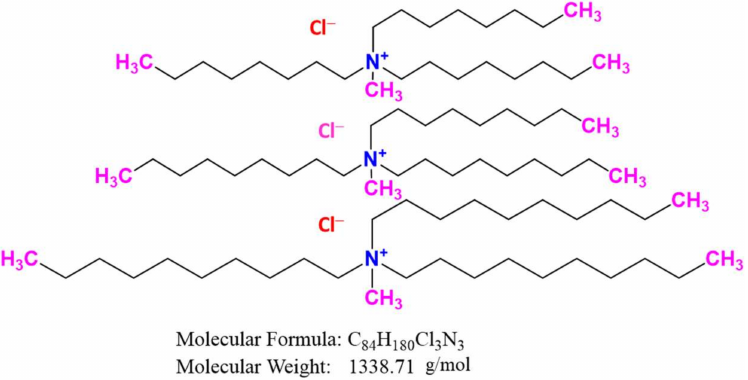
Figure 12. Structure of Adogen ® 464.